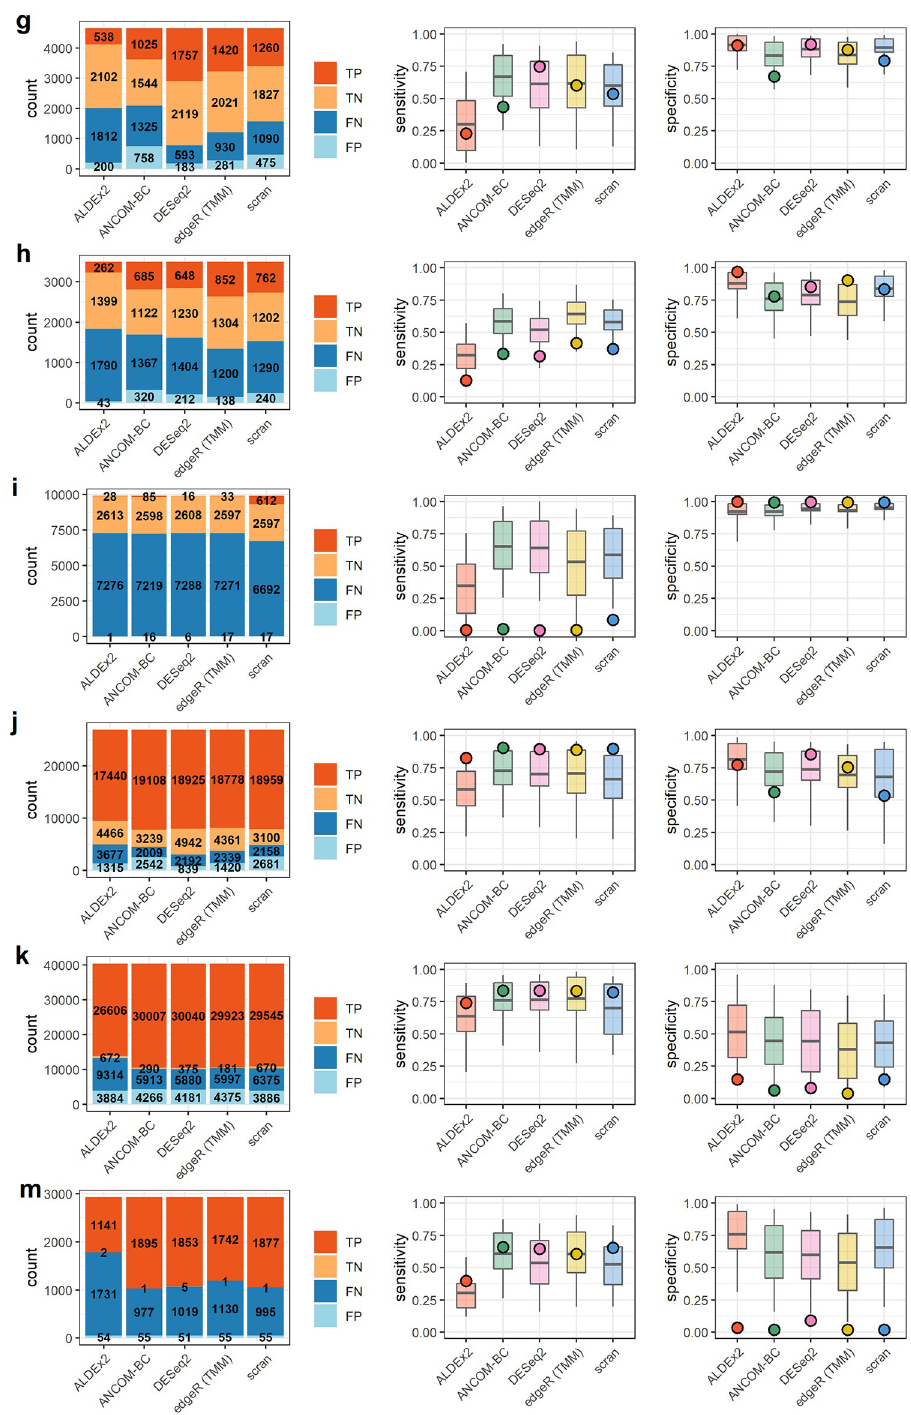
Fig 6. Results for real data sets 7–12. Results summaries for g) Gru¨n et al. h) Muraro et al. i) Kimmerling et al. j) Yu et al. k) Owens et al. m) Klein et al. Barplots on the left indicate counts of true and false positives (TP, FP) and true and false negatives (TN, FN). Boxplots on the right indicate the 50% (box) and 90% (line) intervals of prediction and points, the observed values of either sensitivity or specificity.